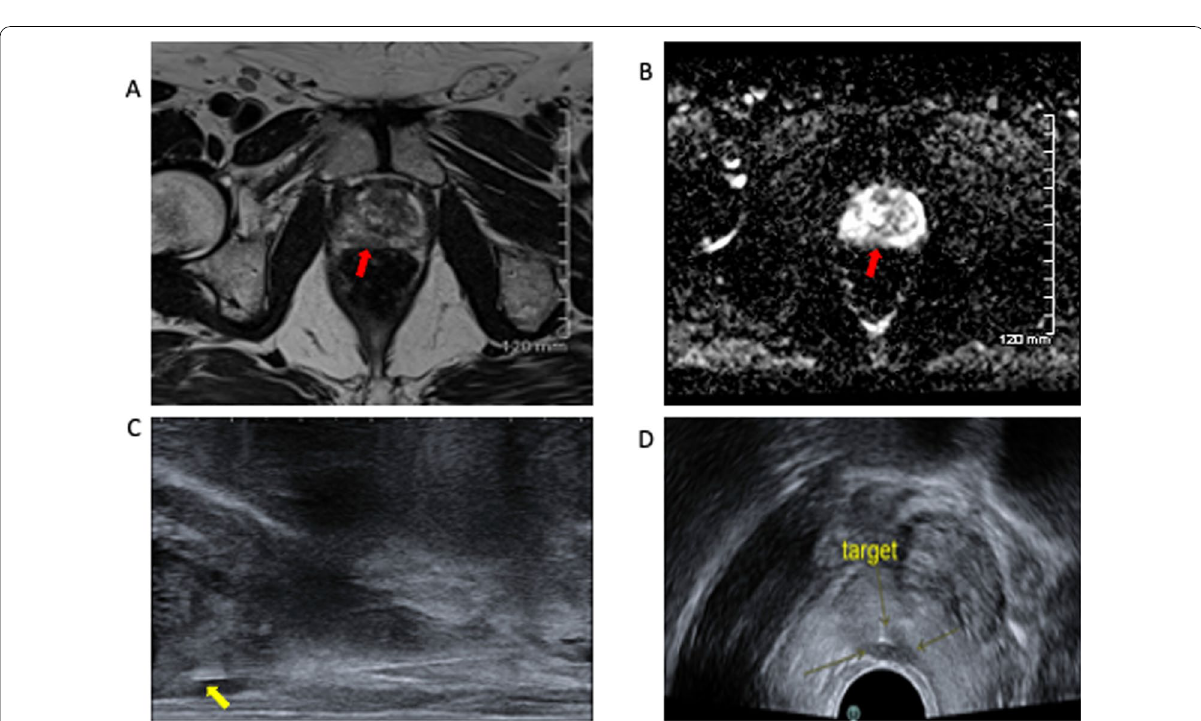
Fig. 15 Another example of a PIRADS 5 lesion on T2-weighted imaging ( A ) and the ADC map ( B ). The needle position is confirmed to be within the lesion at time of biopsy on both sagittal images ( C ) and axial ( D